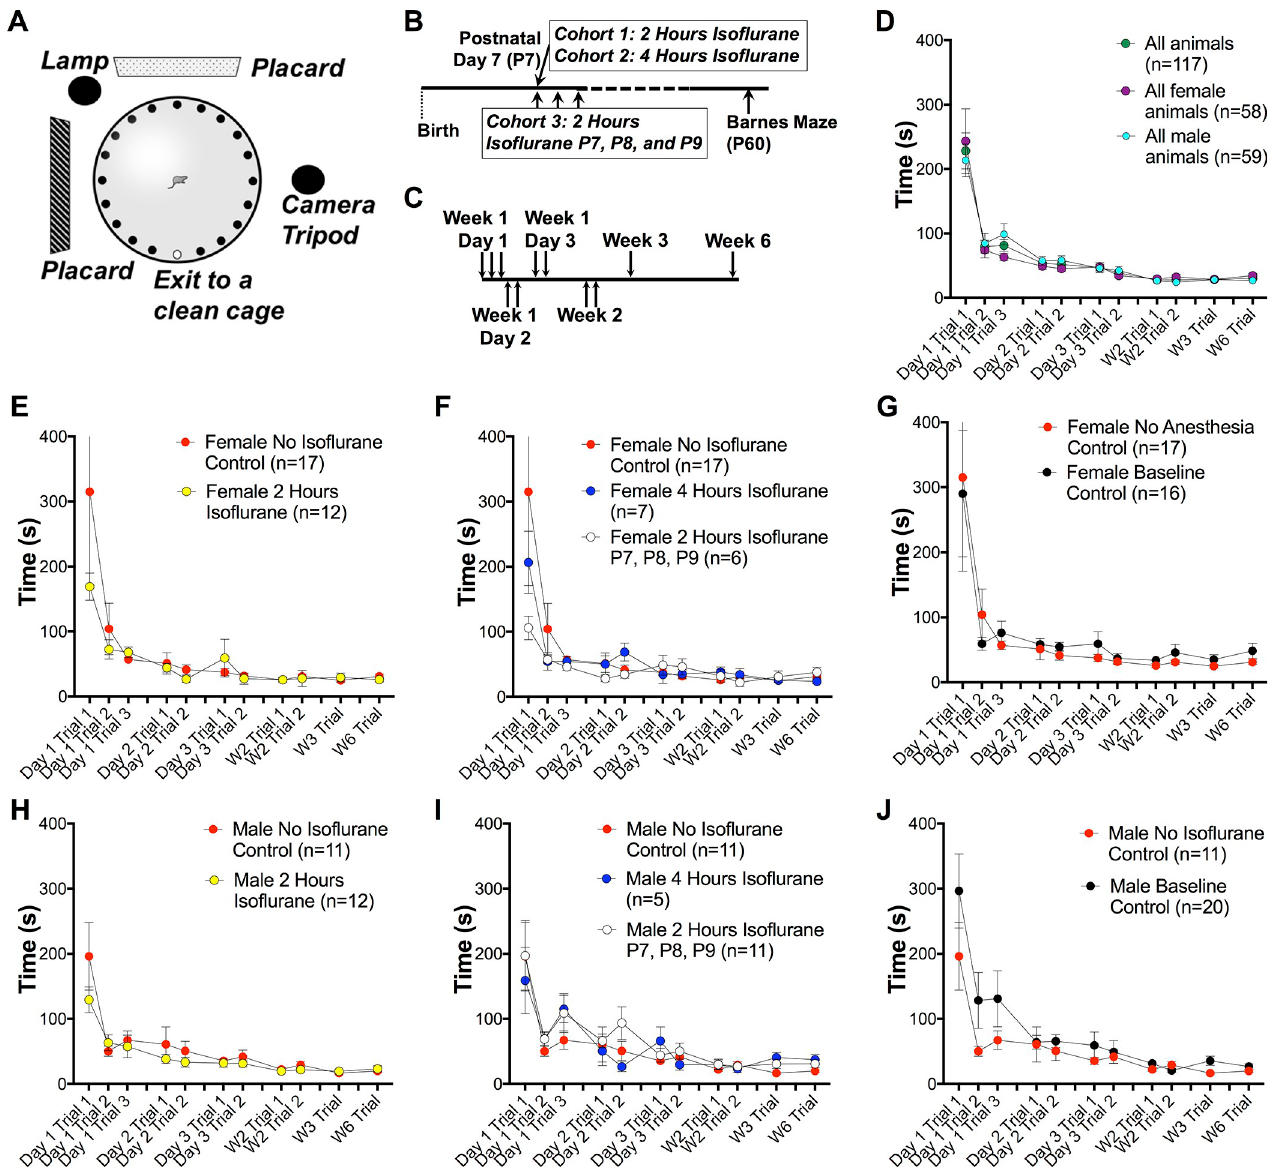
Fig 4. Cognitive outcomes in anesthesia exposed P7 neonatal mice. ( A ) Barnes maze setup and Barnes maze testing paradigm (see Methods for details and specifications). ( B ) Timeline of anesthesia treatment and Barnes maze assessment and anesthesia paradigms explored in this study. ( C ) Barnes maze paradigm utilized in this study. ( D ) Composite data from all mice from all treatment cohorts. ( E, H ) Assessment of female ( E ) and male ( H ) animals treated with 2 hours of anesthesia with 1.5% isoflurane mice compared to mock treated controls (see Methods). ( F, I ) Assessment of female ( F ) and male ( I ) animals treated with 4 hours of anesthesia with 1.5% isoflurane or treated 2 hours of 1.5% isoflurane daily for three days compared to mock treated controls (see Methods). ( G, J ) Assessment of female ( G ) and male ( J ) animals given mock treatment compared to animals receiving no handling (aside from routine animal maintenance) prior to behavioral assessment (see Methods). Animal numbers are listed in every panel; in all panels data points represent the mean, error bars represent SEM. Row by row comparisons by pairwise t-tests yielded no significant differences (by p-value < 0.05 cutoff) at any time point in any paradigm, even when no multiple testing correction was applied and thus the least stringent criteria for statistical significance